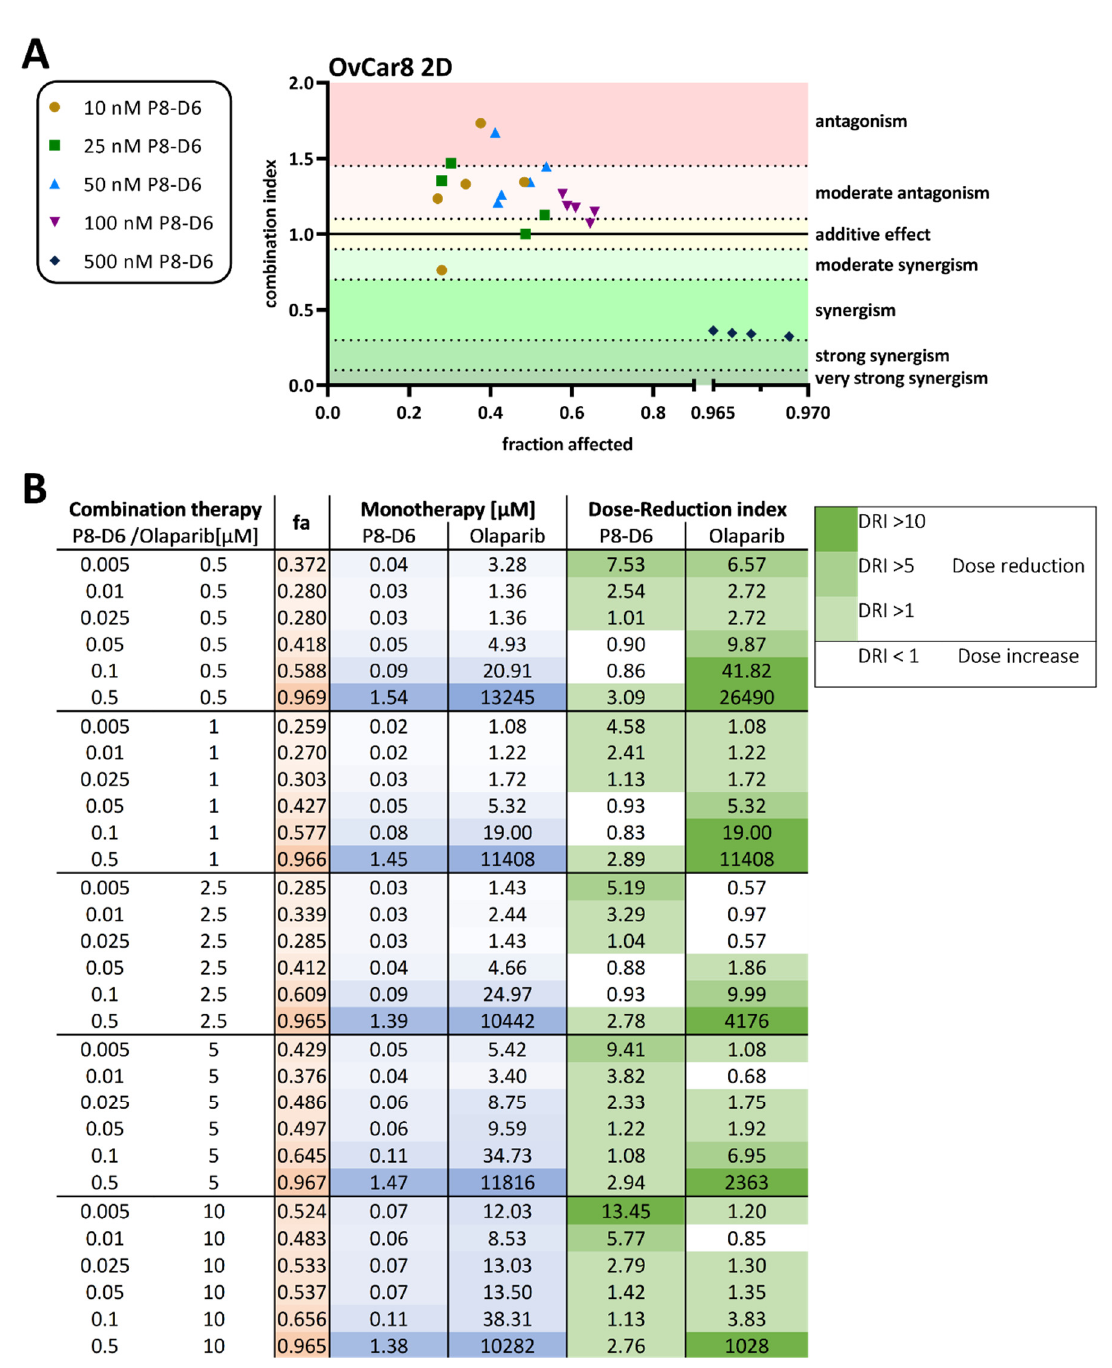
Figure 3. Combination index (CI) analysis of olaparib in combination with P8-D6 in OC 2D culture. ( A ) Combination index (CI) for drug combinations by olaparib and P8-D6 in OvCar8 cells. CI values computed according to CompuSyn software with viability data. Combinations were considered synergistic when CIs were below 1.0. The fraction affected (fa)-value represents the fraction of cell viability affected by therapy. ( B ) The monotherapy column defines the concentrations that are needed in monotherapy to affect a certain fraction of cells by therapy. DRI values represent the order of magnitude (fold) of dose reduction in combination setting compared with each drug alone.